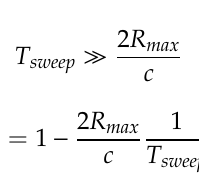
Figure 15. MIMO working principle, N TX transmitting antennas with N RX receiving antennas are equivalent to N TX (cid:3400) N RX “virtual” antennas.